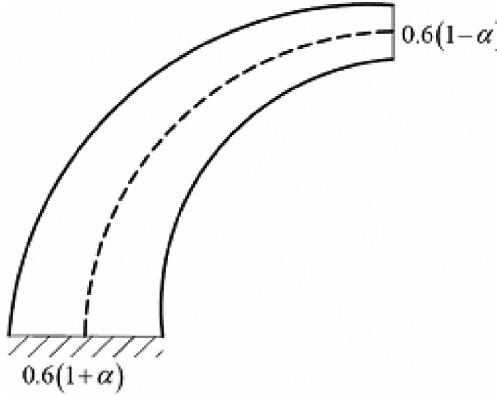
Fig. 6. A tapered quadrant with linearly varying